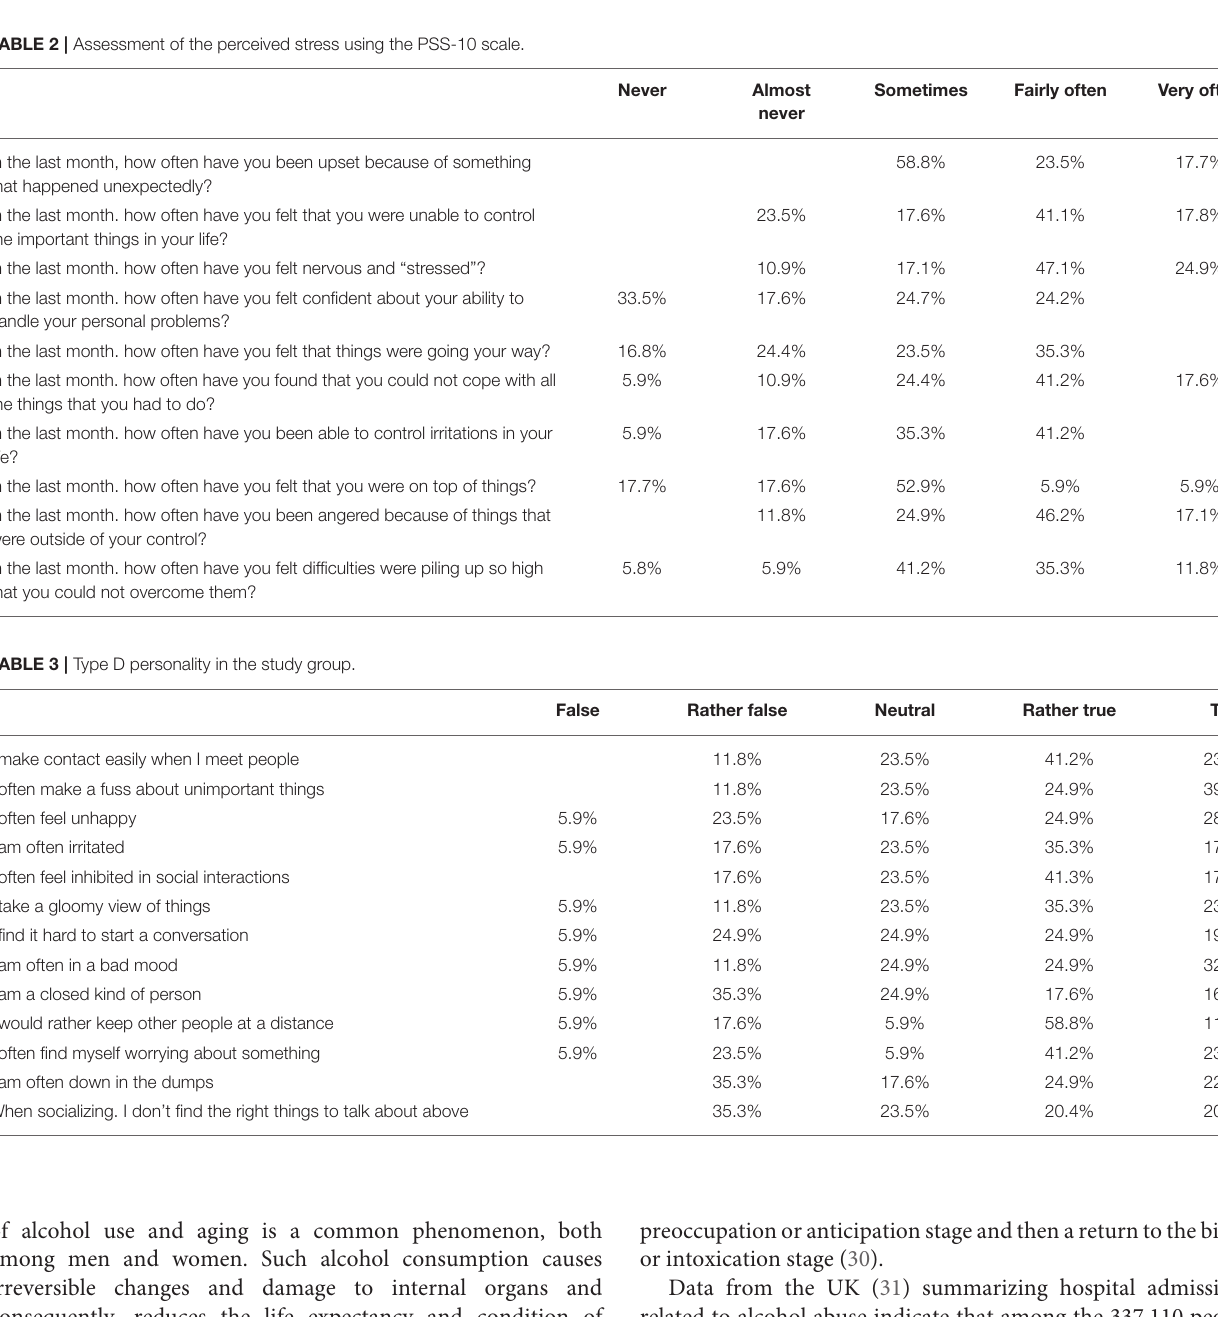
TABLE 2 | Assessment of the perceived stress using the PSS-10 scale.